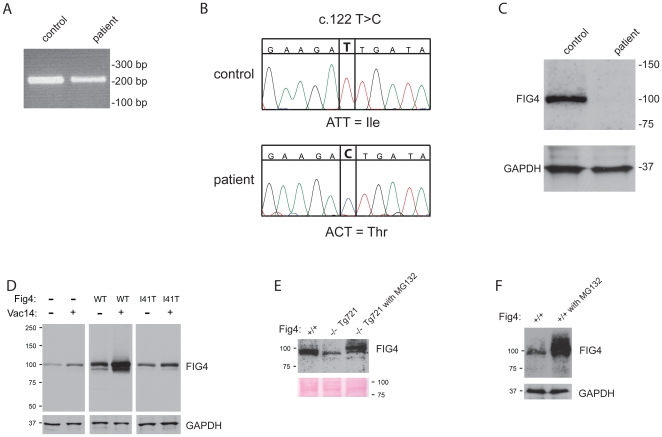

FIG4 transcript and protein in CMT4J patient fibroblasts.A) RT-PCR products containing exon 2 were amplified from total fibroblast RNA with a forward primer in exon 1 and reverse primer in exon 3. B) Sequence of the RT-PCR product demonstrating nucleotide c.122T (isoleucine) in the control RNA and nucleotide c.122C (threonine) in the patient RNA. C) Western blot of 60 ug of protein from patient and control fibroblasts. D) HEK293T cells transfected with wildtype mouse FIG4 cDNA transgene (Figure 3) or the corresponding I41T construct. Co-transfection of VAC14 stabilizes endogenous and transfected FIG4 proteins. E) The low level of FIG4 in primary fibroblasts from Tg721 transgenic mice is increased by culture for 8 hours in the presence of 10 uM concentration of the proteasome inhibitor MG-132. F) Incubation of wildtype fibroblasts with MG-132 increases the level of FIG4 protein.